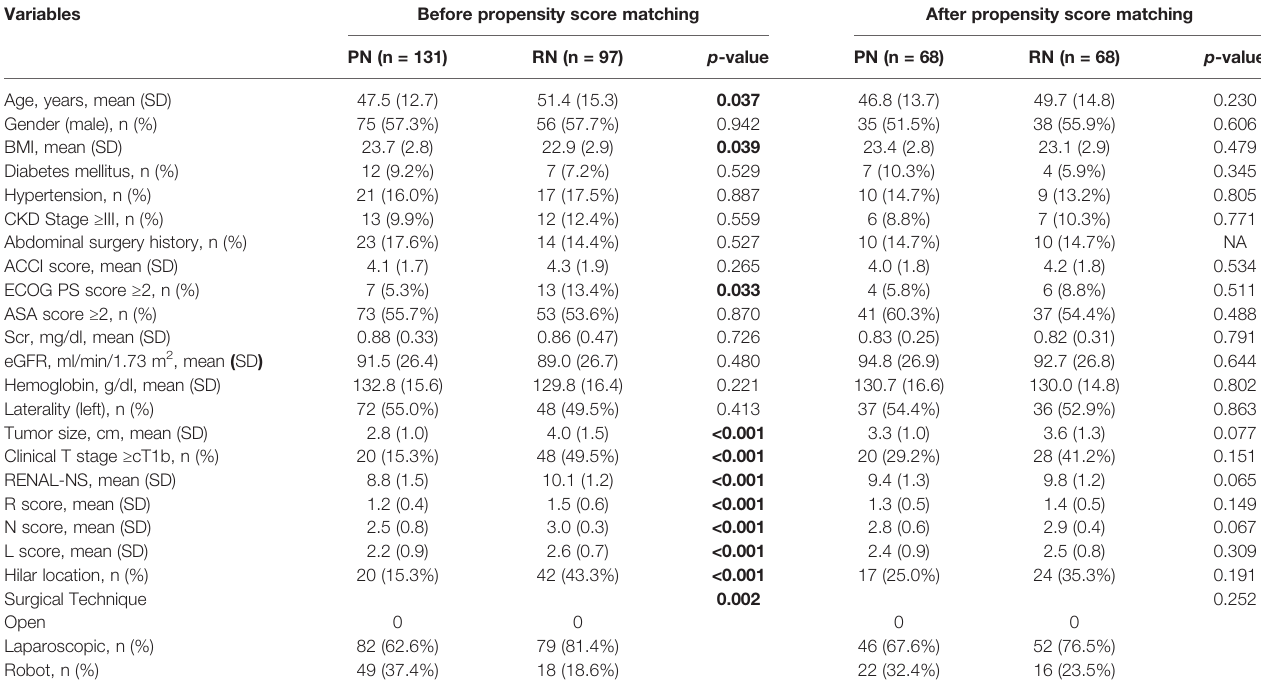
TABLE 1 | Preoperative basic characteristics of patients before and after propensity score matching. Variables Before propensity score